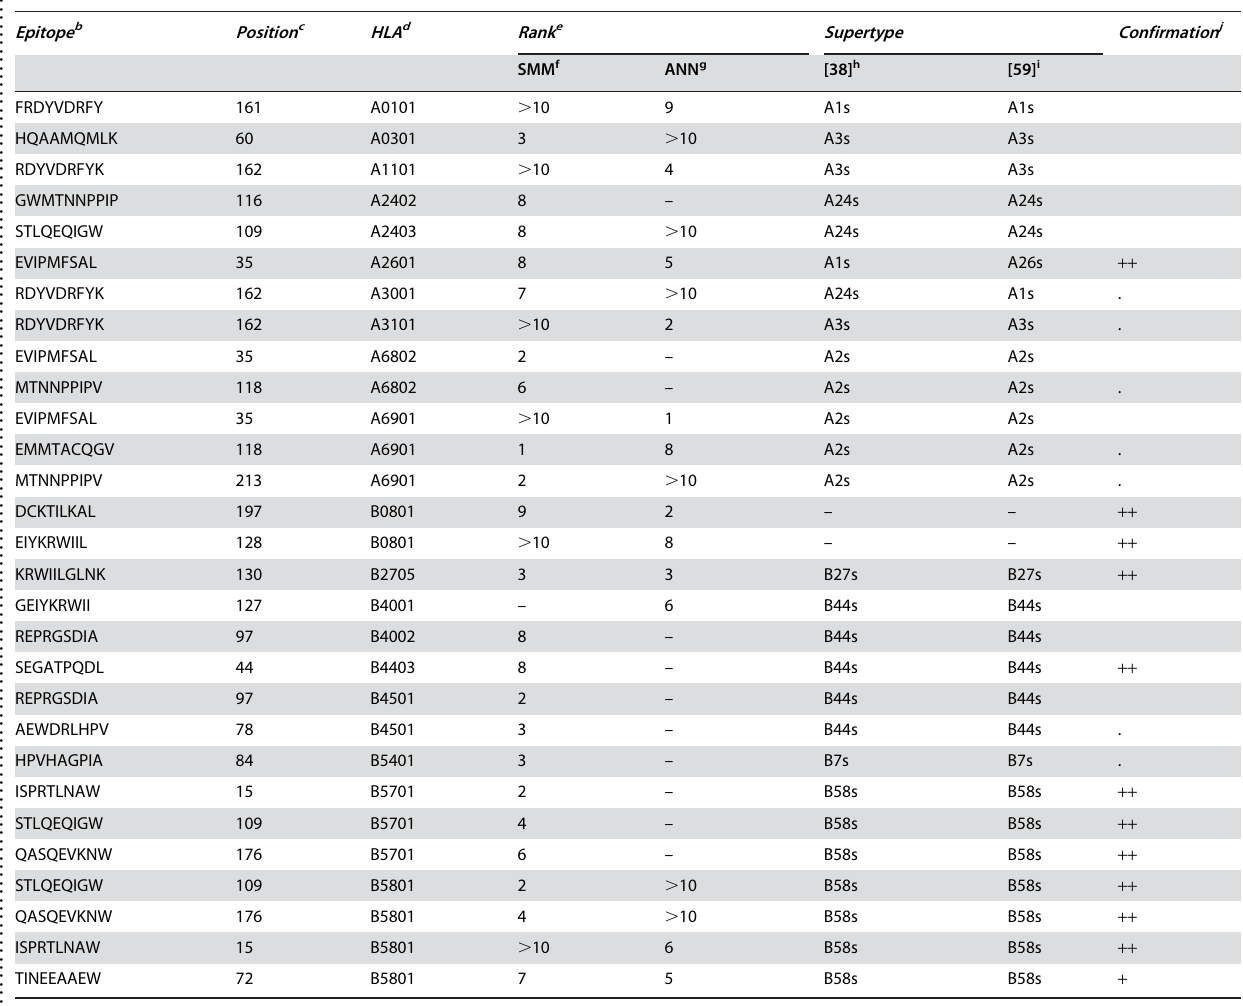
Table 1. Predicted p24 epitopes with a high ranking a HLA-binding affinity score. .. ... .... ... ... .... ... ... .... ... ... .... ... ... .... ... ... .... ... ... .... ... ... .... ... ... .... ... ... .... ... ... .... ... ... .... ... ... .... ... ... .... ... ... . Epitope